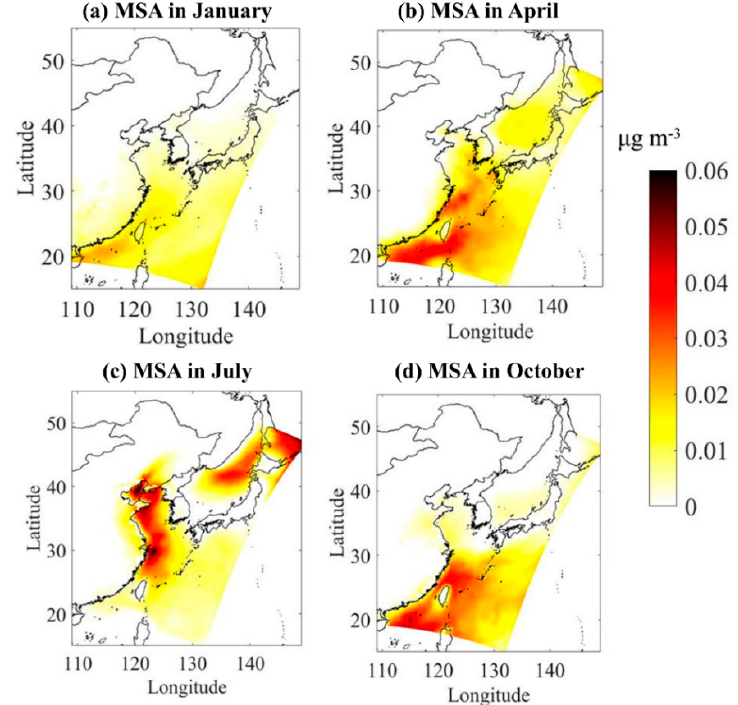
Figure 6. The spatial distribution of atmospheric gas-phase MSA in four typical months of ( a ) January, ( b ) April, ( c ) July, and ( d ) October.